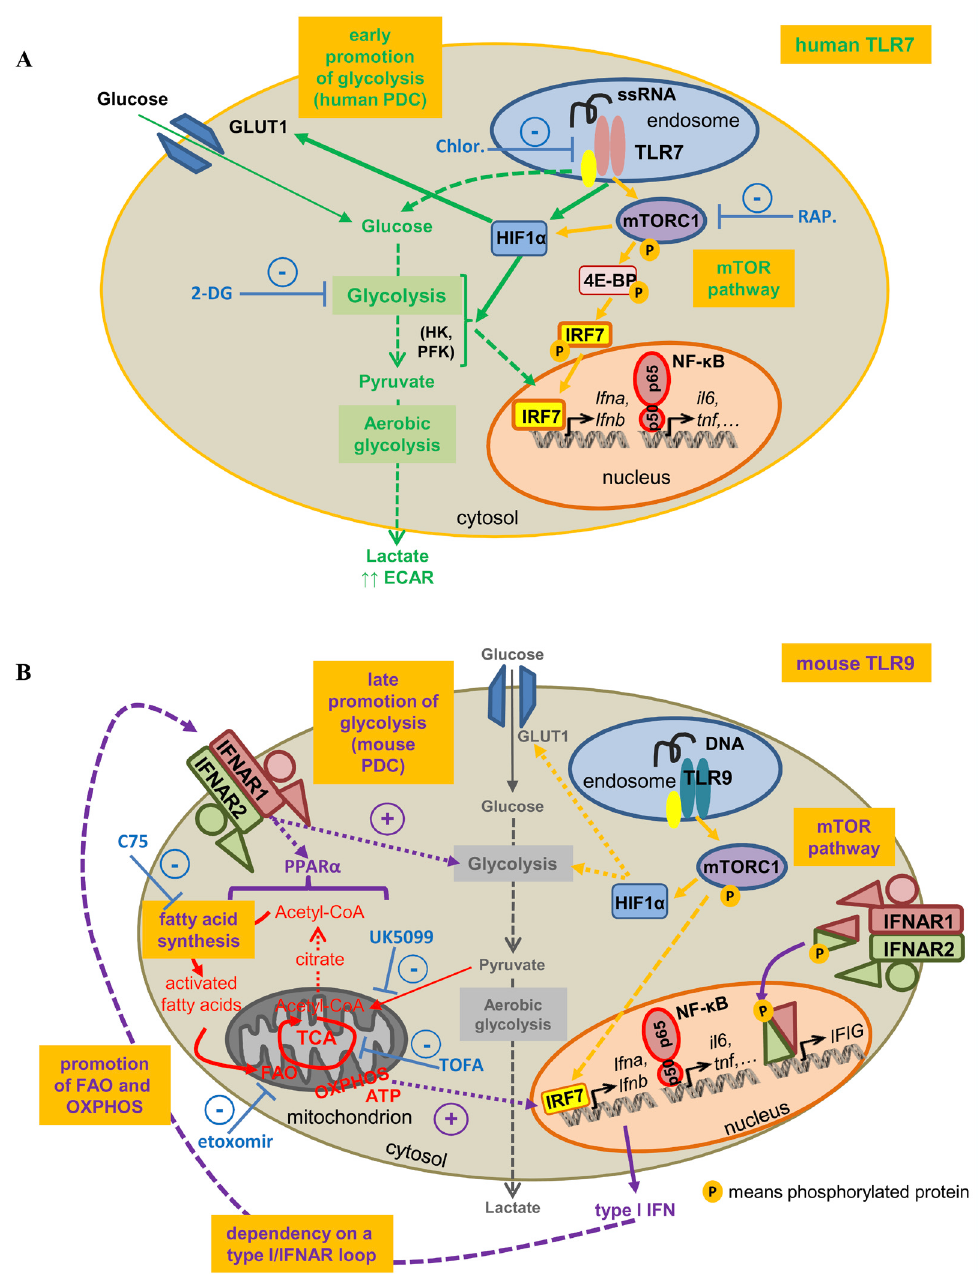
Figure 2. Metabolic changes in plasmacytoid dendritic cells (PDC) providing energy and affecting their innate immune functions: glycolysis versus fatty acid oxidation coupled with OXPHOS. ( A ) The endosomal TLR7 pathway in human blood-derived PDC promotes early glycolysis (within minutes following TLR7 triggering; green font and green arrows), as attested by increased ECAR (extracellular acidification rate; a reflection of lactate excretion). This implicates the HIF-1 α molecule that increases the GLUT1 glucose transporter expression allowing extracellular glucose entry. HIF-1 α stimulates some enzymes involved in glycolysis (HK or PFK). Glycolysis in human PDC is required for TLR7-induced type I IFN production. A potential link with the activation of the mTORC1 complex (orange arrows) can be seen, since this complex is activated by the endosomal TLR7 pathway and induces HIF-1 α in human PDC. Inhibitors of mTORC1 (RAP.), of TLR7 signaling (chlor.), and of glycolysis (2-DG) are written in blue font. All these inhibitors block TLR7-induced type I IFN production. ( B ) The TLR9 pathway in mouse bone marrow-derived PDC promotes late glycolysis (after 24 hours) (grey font and grey arrows) via a type I IFN/IFNAR loop (violet arrows). Through this loop, the TLR9 pathway also promotes fatty acid synthesis, FAO coupled with OXPHOS to generate ATP in a PPAR α -dependent mechanism (violet font and violet arrows). This TLR9 pathway implicates the activation of mTORC1 in mouse PDC (orange arrows, as depicted in Figure 2A). Specific inhibitors of fatty acid synthesis (C75), pyruvate entry in the mitochondrion (UK5099), TCA cycle (TOFA) or FAO (etoxomir) are written in blue font and have been used to demonstrate the promotion of fatty acid synthesis, FAO and OXPHOS in TLR9-induced type I IFN production, respectively. For more details, please refer to the main text. Abbreviations (not defined in the main text): HK, hexokinase; PFK, phosphofructokinase; RAP., rapamycin; chlor.,